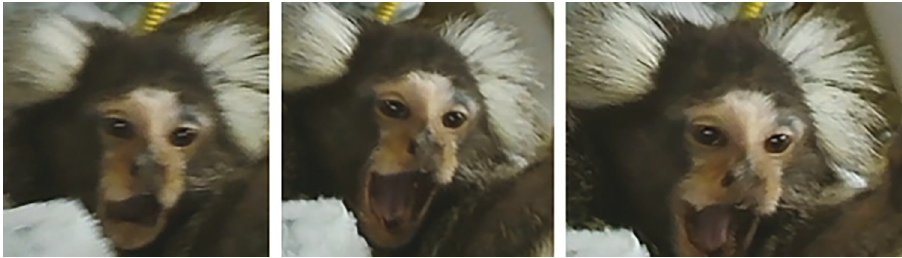
Fig 13. AU12—Lip Corner Puller. Left: AU25 and AU27 are present; Centre: AU12 is added to AU25+AU27; Right: AU110 is added to AU25+AU27+AU12.